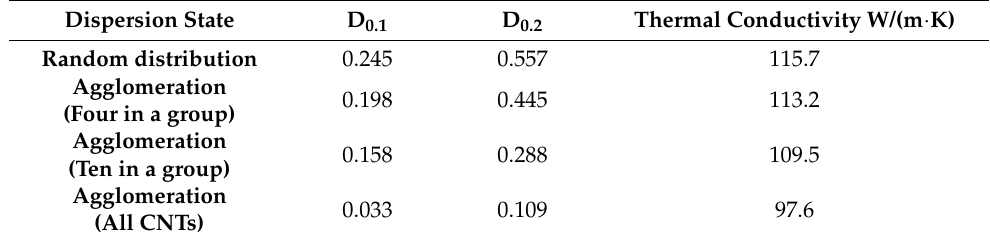
Table 3. Calculation results of thermal conductivity of four models.